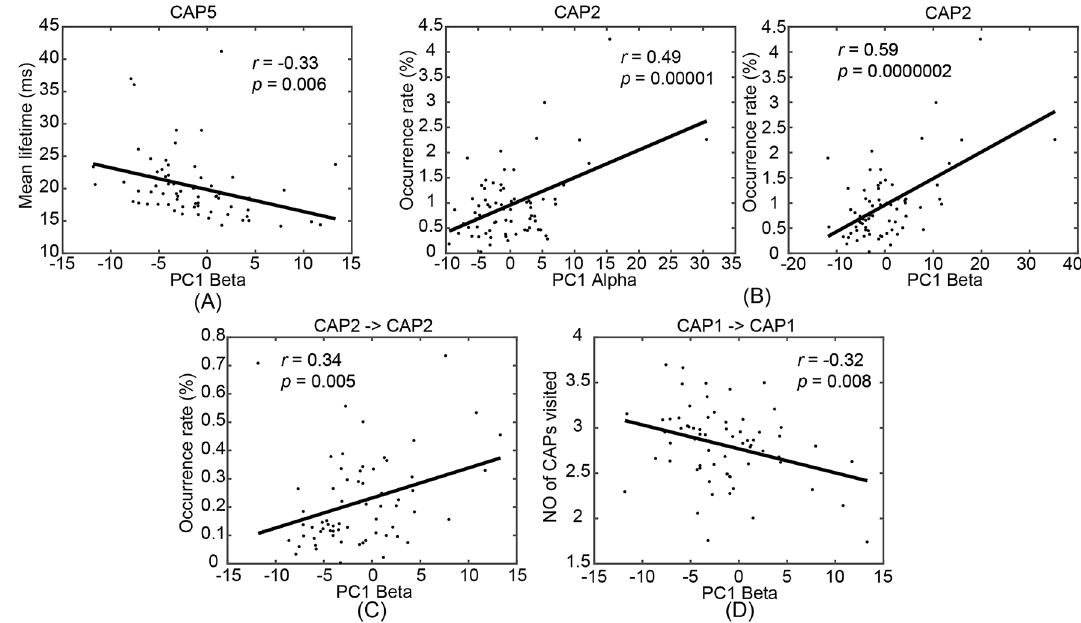
Figure 7. Significant correlations between age-related PCA-based static power measures and CAP-based dynamic measures ( p < 0.01, FDR corrected). ( A ) Beta-band PC scores vs. CAP5 lifetimes; ( B ) Alpha- and beta- band PC scores vs. CAP2 occurrence rates; ( C ) Beta-band PC scores vs. CAP2 → CAP2 occurrence rates; ( D ) Beta-band PC scores vs. numeric counts of other CAPs visited in CAP1 → CAP1. The line in each panel denotes the linear regression model, while p and r values obtained from correlational analysis are listed.